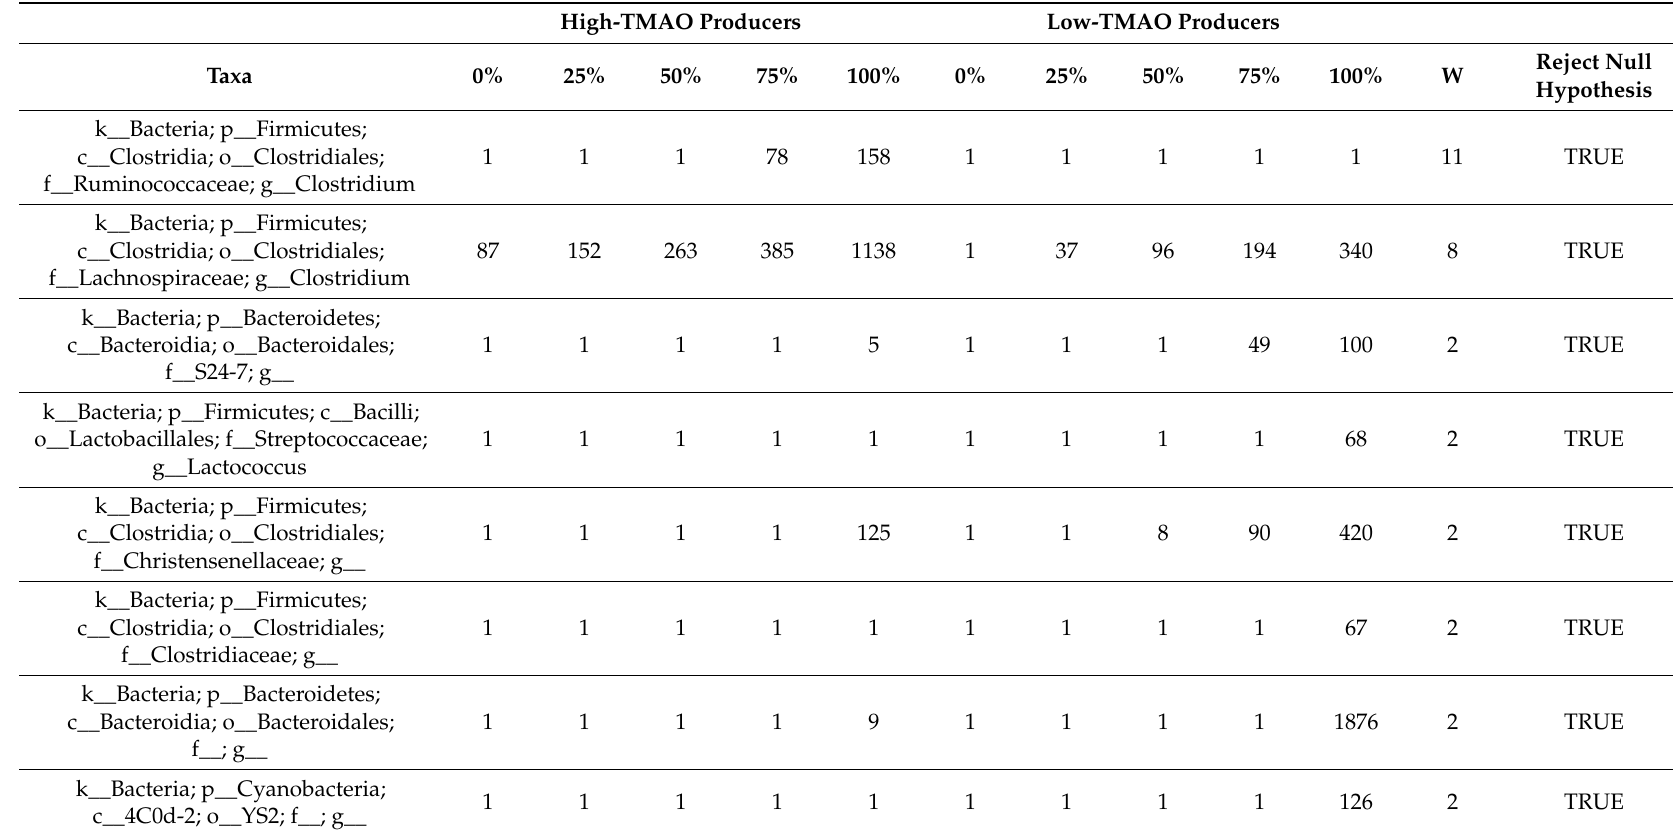
Table 4. Analysis of Composition of Microbiomes (ANCOM) results showing percentile abundances of taxa at genus level and W-statistics for high-trimethylamine- N -oxide (TMAO) producers ( n = 17; those with ≥ 40% urinary TMAO increase from 0 min study-baseline in response to choline bitartrate) versus low-TMAO producers ( n = 17; those with < 40% urinary TMAO increase from 0 min study-baseline in response to choline